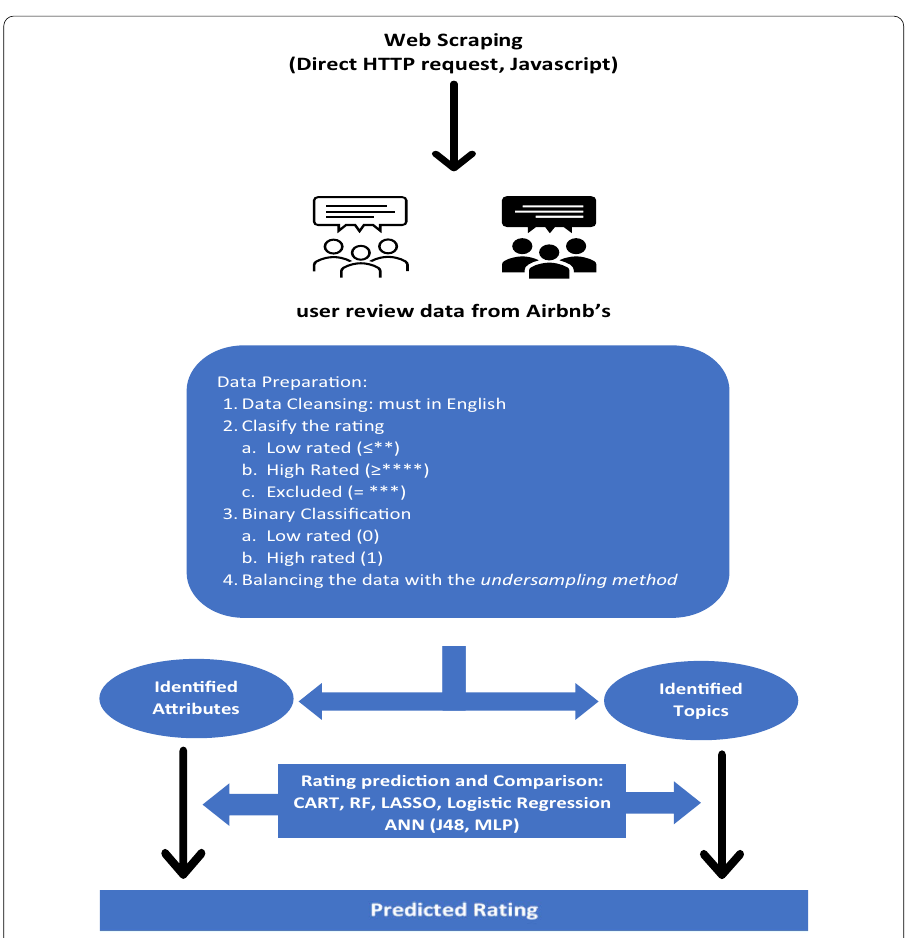
Fig. 1 The step by step rating prediction. Flowchart in general of the study from the start to the end process to predict the rating from the